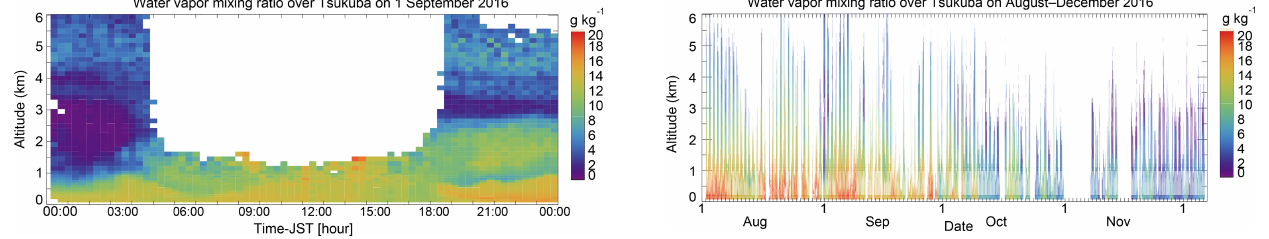
Figure 7. Altitude–time cross section of water vapor mixing ratios obtained with the MRL on 1 September 2016. Data with uncertainty of less than 30% are plotted. Arrows at the bottom show the start of the measurement periods for the data shown in Fig. 6.